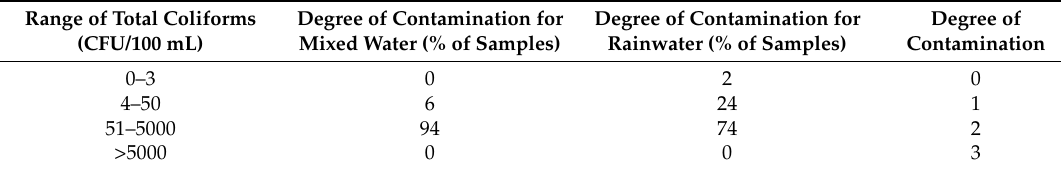
Table 6. Water contamination with total Coliforms in Yatta